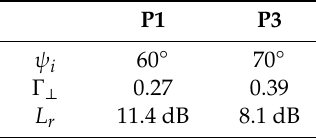
Table 1. The grazing angles, reflection coe ffi cients and reflection power loss of P1 and P3.